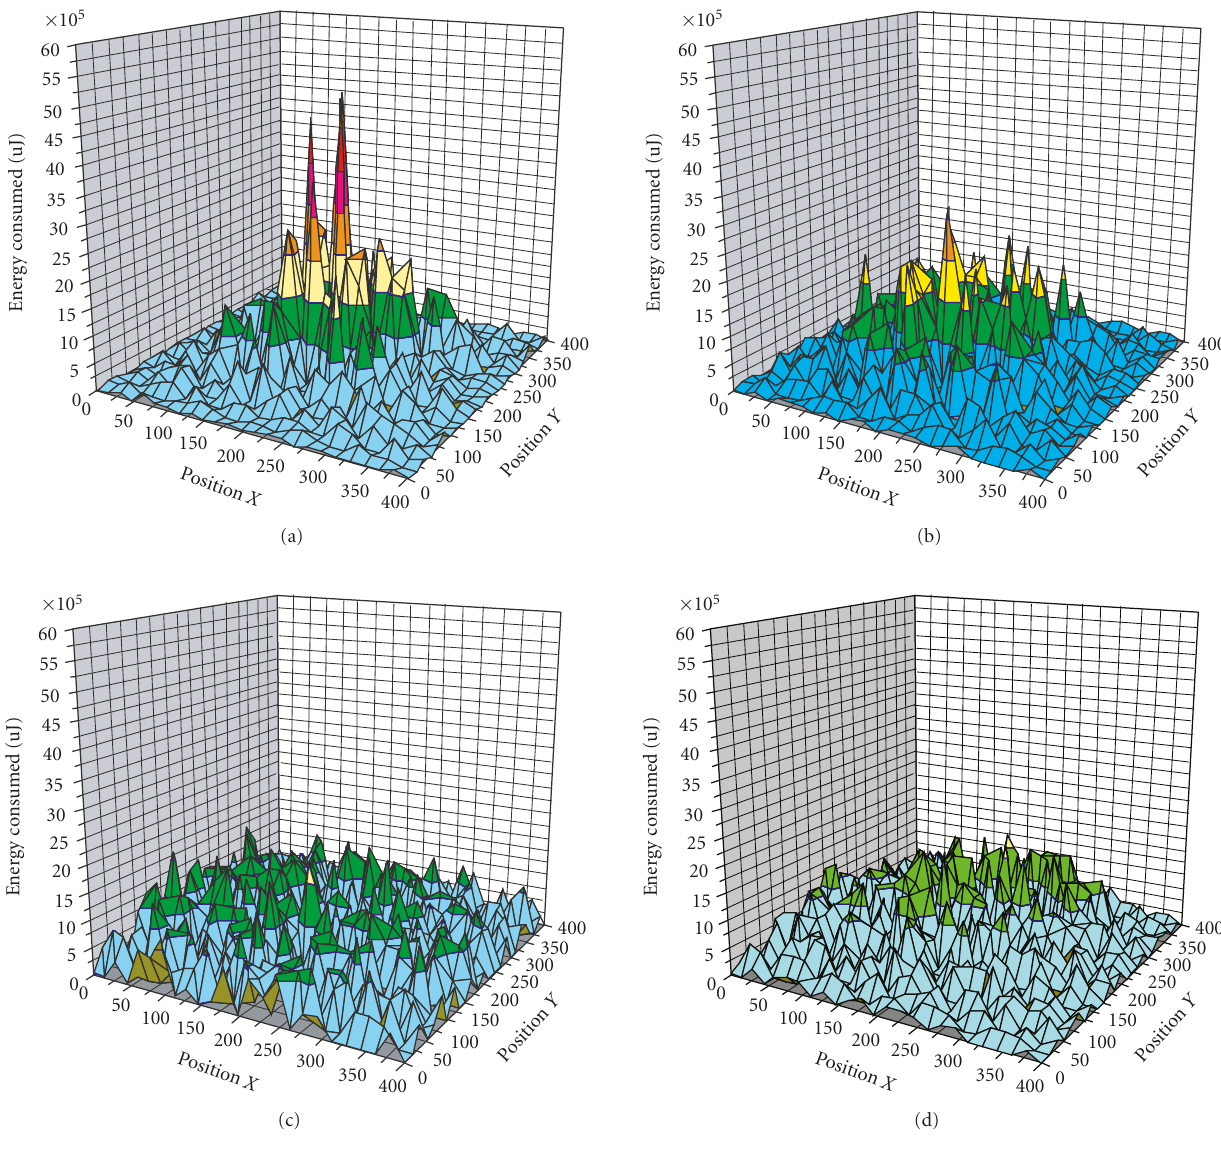
Figure 9: The snapshots of the energy consumption of the sensor nodes when the simulations were running in a network that had 400 sensor nodes in a region of 400m × 400m. (The initial energy for each node is 8J.) (a) Stationary scheme; (b) random moving strategy; (c) peripheral moving strategy; (d)